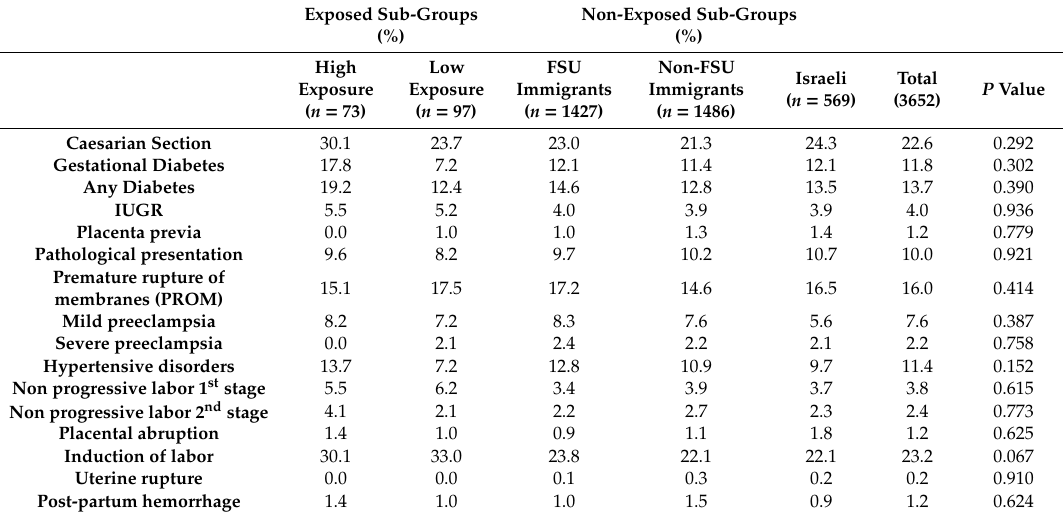
Table 2. Obstetric outcomes of the study groups.